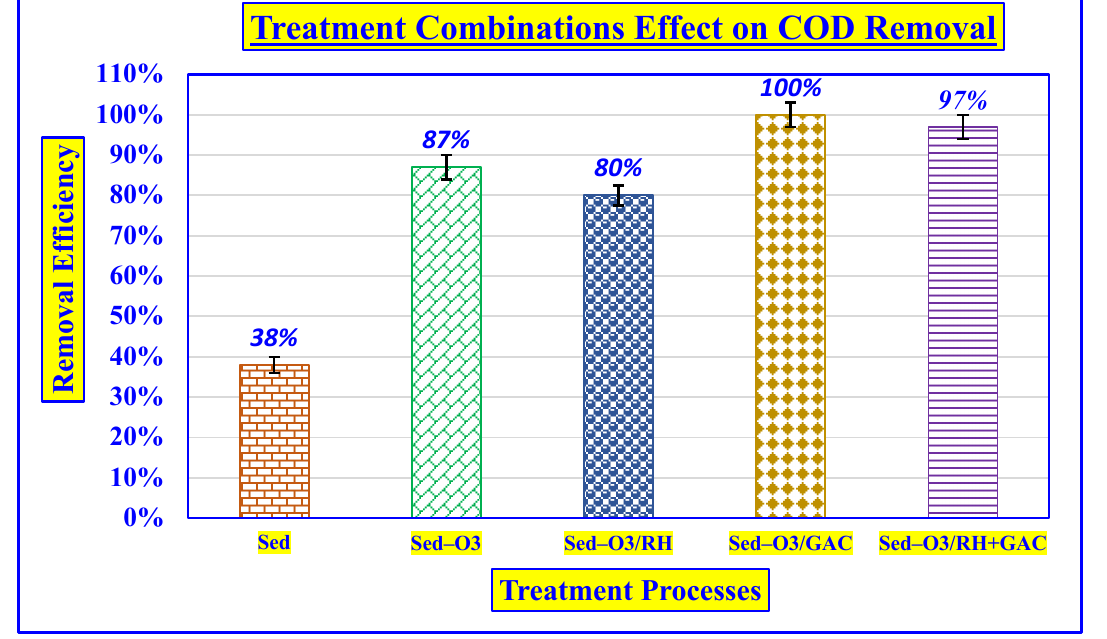
Figure 4. COD removal by different combinations (Initial COD= 490 mg/L; O 3 = 82.5 ± 2.2 mg/L; peristaltic pump speed = 150 rpm; C. T= 18 min; GAC= 400 g; RH= 400 g; GAC + RH = 200 g +200 g; pH = 6.9 ± 0.2; volume = 4 L; T = 25 ± 2 C).